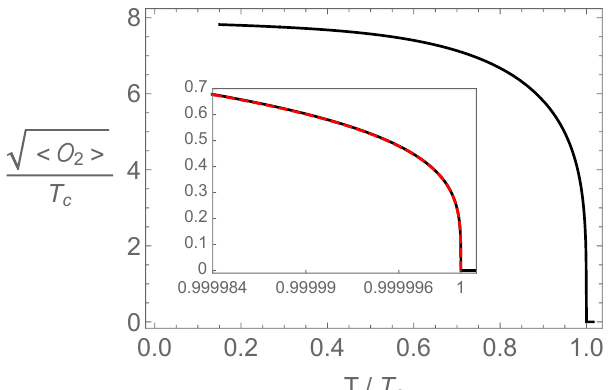
Figure 2 . Order parameter h O 2 i vs. reduced temperature T/T c . The critical temperature is T c /µ = 0 . 0587 . The inset shows the near-critical mean field behavior: numerical result (solid black), fitting result (4.1) (dashed